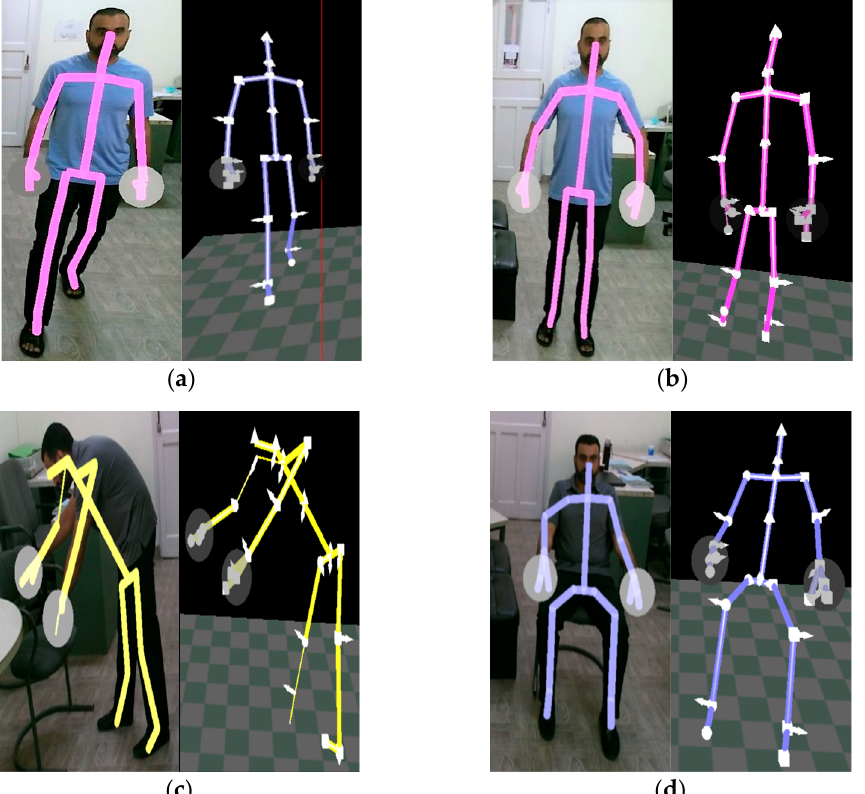
Figure 12. Ground-truth data for ( a ) walking activity ( b ) standing ( c ) bending and ( d ) sitting.